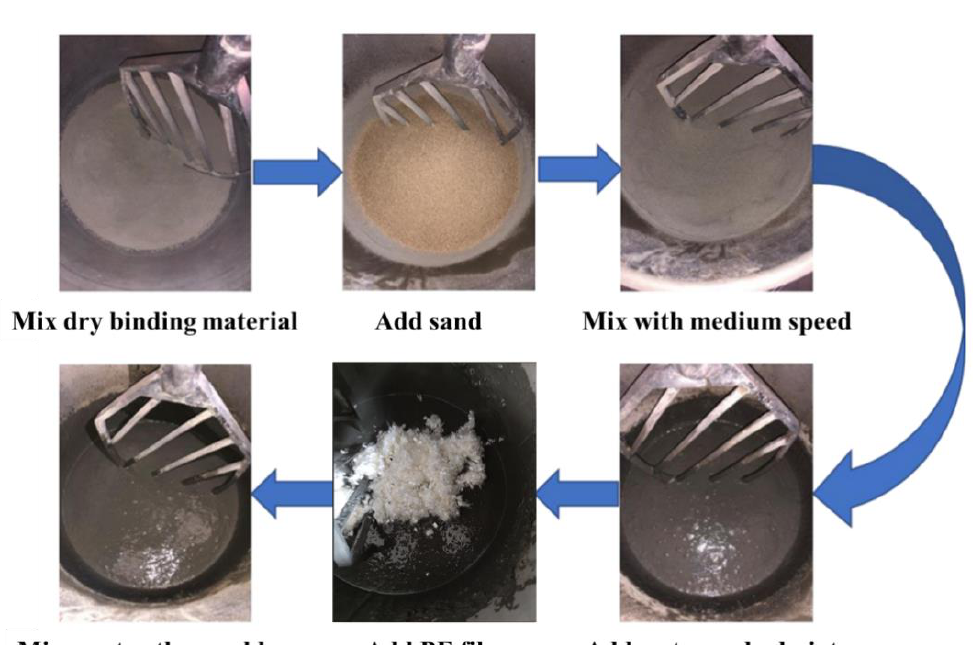
Figure 1 . Morphology of PE fiber. Figure 1. Morphology of PE fiber.